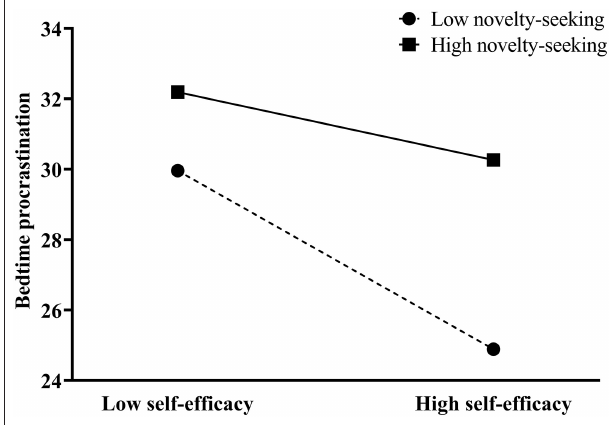
FIGURE 2 | The moderation effect of novelty seeking on self-efficacy to bedtime procrastination.